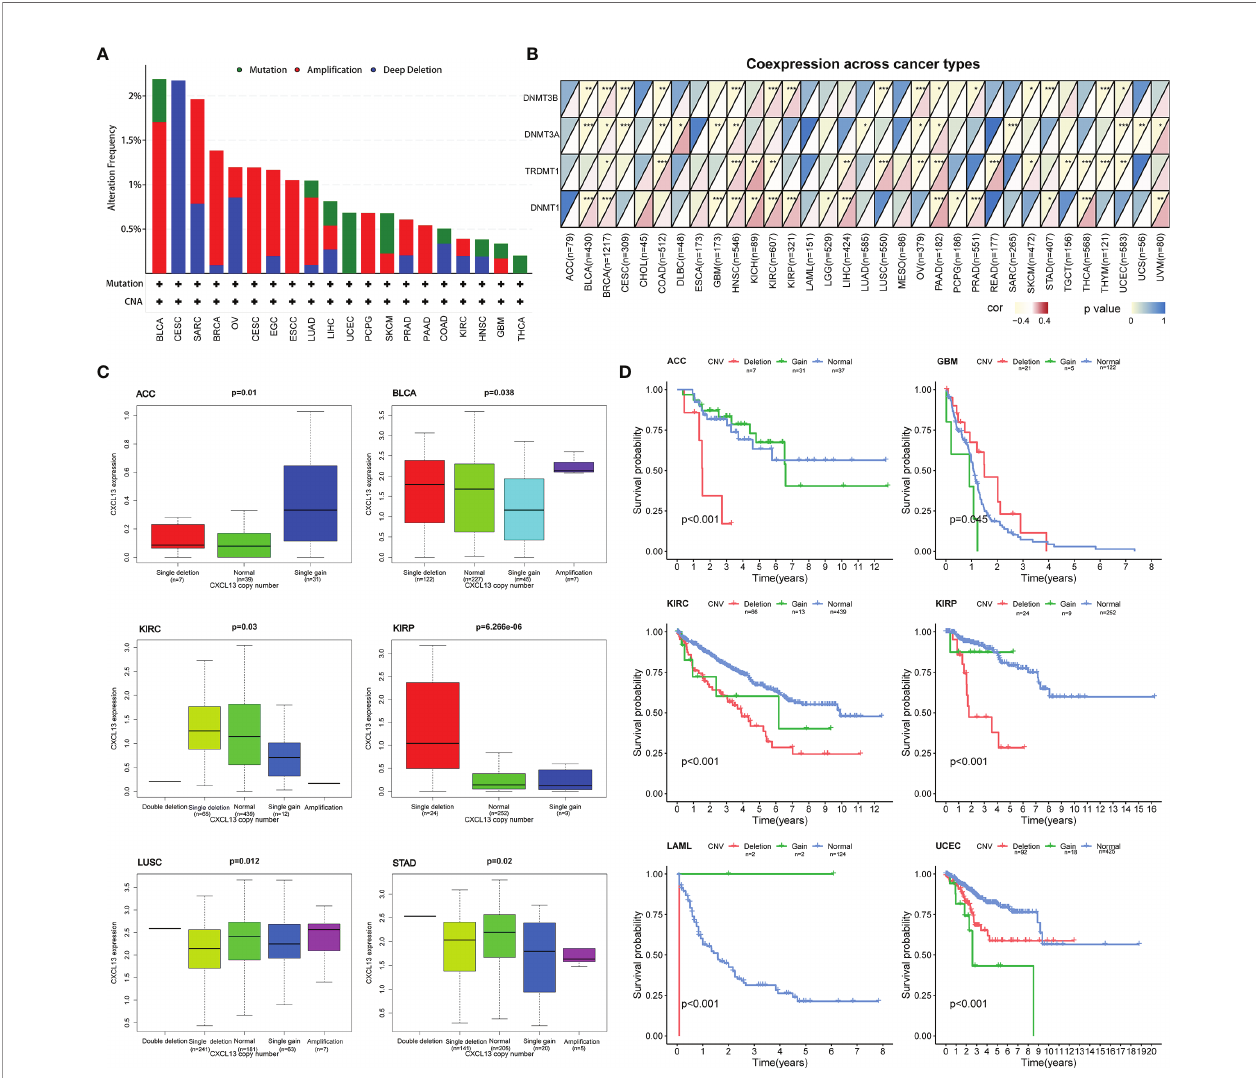
FIGURE 11 | Correlation between CXCL13 expression levels and CXCL13 mutation, CNV, and DNA methyltransferase. (A) The mutation features of CXCL13 for the TCGA tumors using the cBioPortal database. (B) The correlation between CXCL13 expression level and DNA methyltransferase. (C) The correlation between CXCL13 expression level and CXCL13 CNV. (D) The correlation between CXCL13 CNV and overall survival. *P < 0.05, **P < 0.01, ***P <